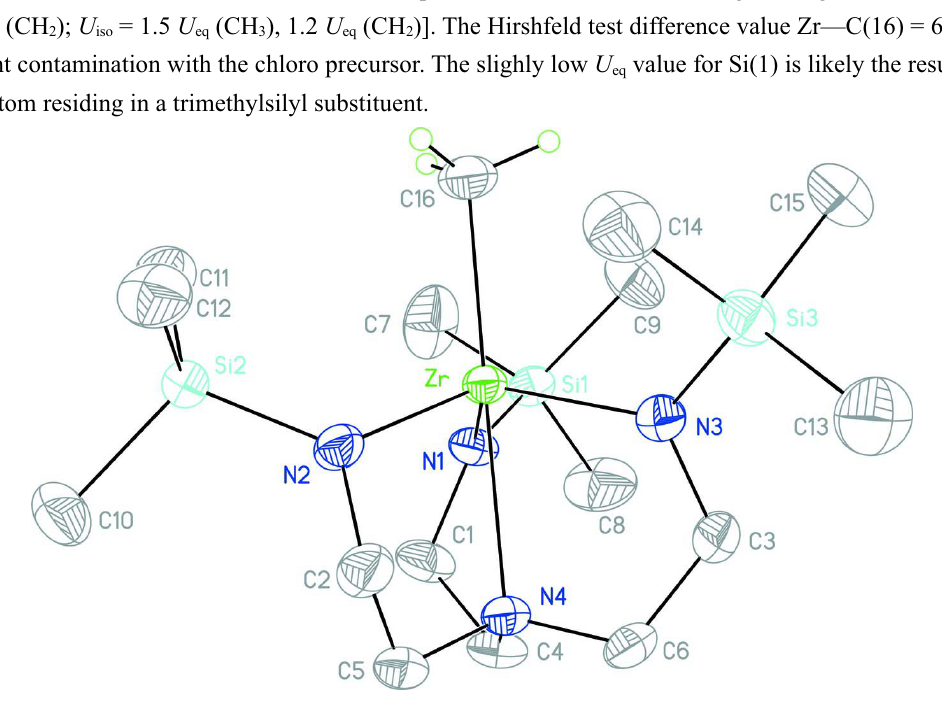
A view of complex I , with displacement ellipsoids shown at the 50% probability level. H atoms except those on C(16)have been omitted for